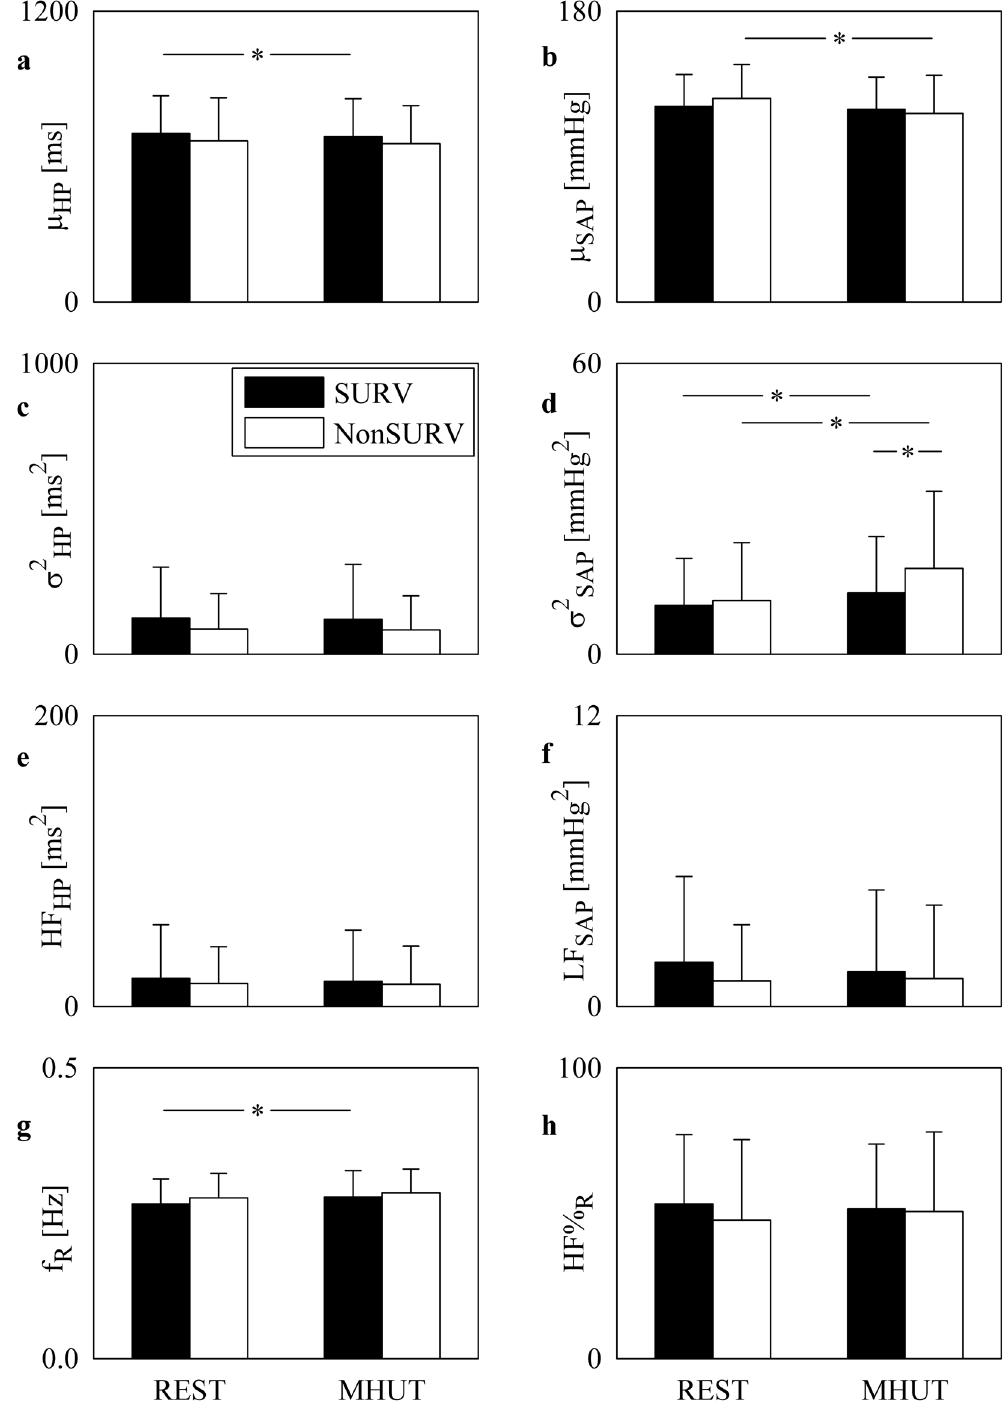
Figure 1. The bar graphs show μ HP ( a ), μ SAP ( b ), σ 2 HP ( c ), σ 2 SAP ( d ), HF HP ( e ), LF SAP ( f ), f R ( g ) and HF% R ( h ) as a function of the experimental condition (i.e. REST and MHUT) in SURVs (dark bar) and NonSURVs (white bar). Data are reported as mean plus standard deviation. The symbol *indicates p <